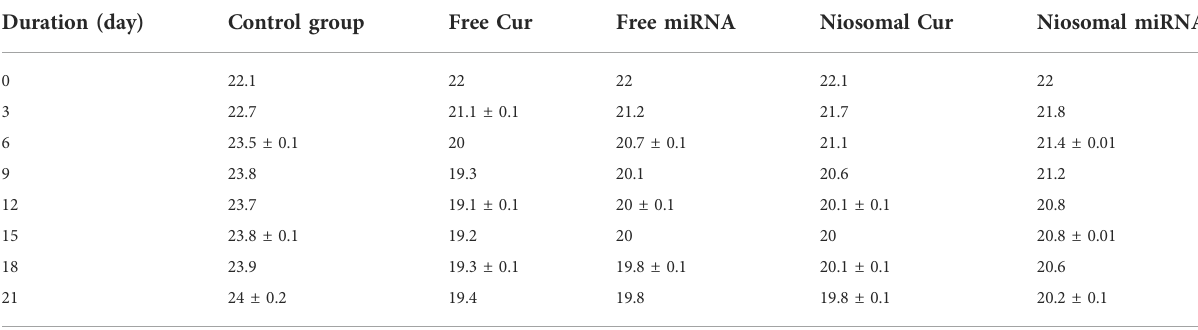
TABLE 3 The measured bodyweight (g) of the mice after receiving different medicine. Duration (day) Control